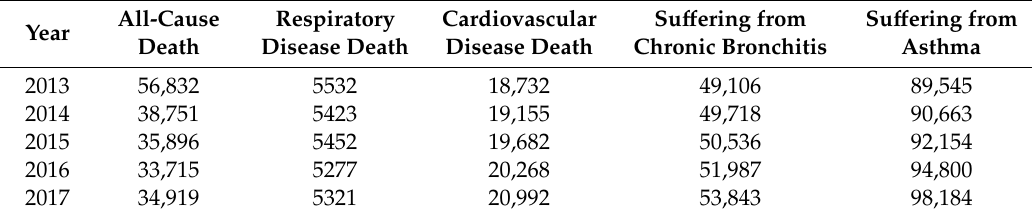
Table 4. Baseline number of health terminals from 2013 to 2017 (unit: person).